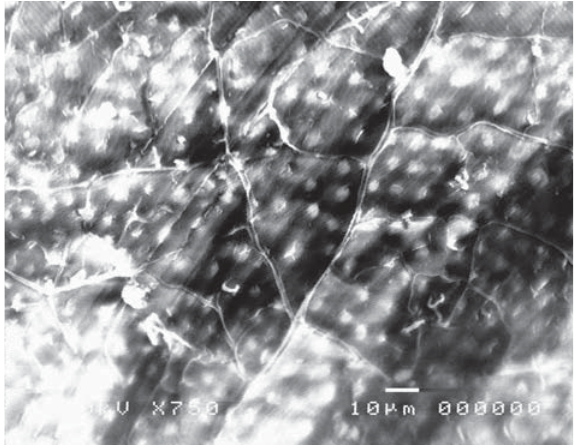
Figure 15- Electron-micrograph in gamma (GB) group subjected to conventional high speed turbine bur after cavity preparation revealing cracks and debris on the dentine surface